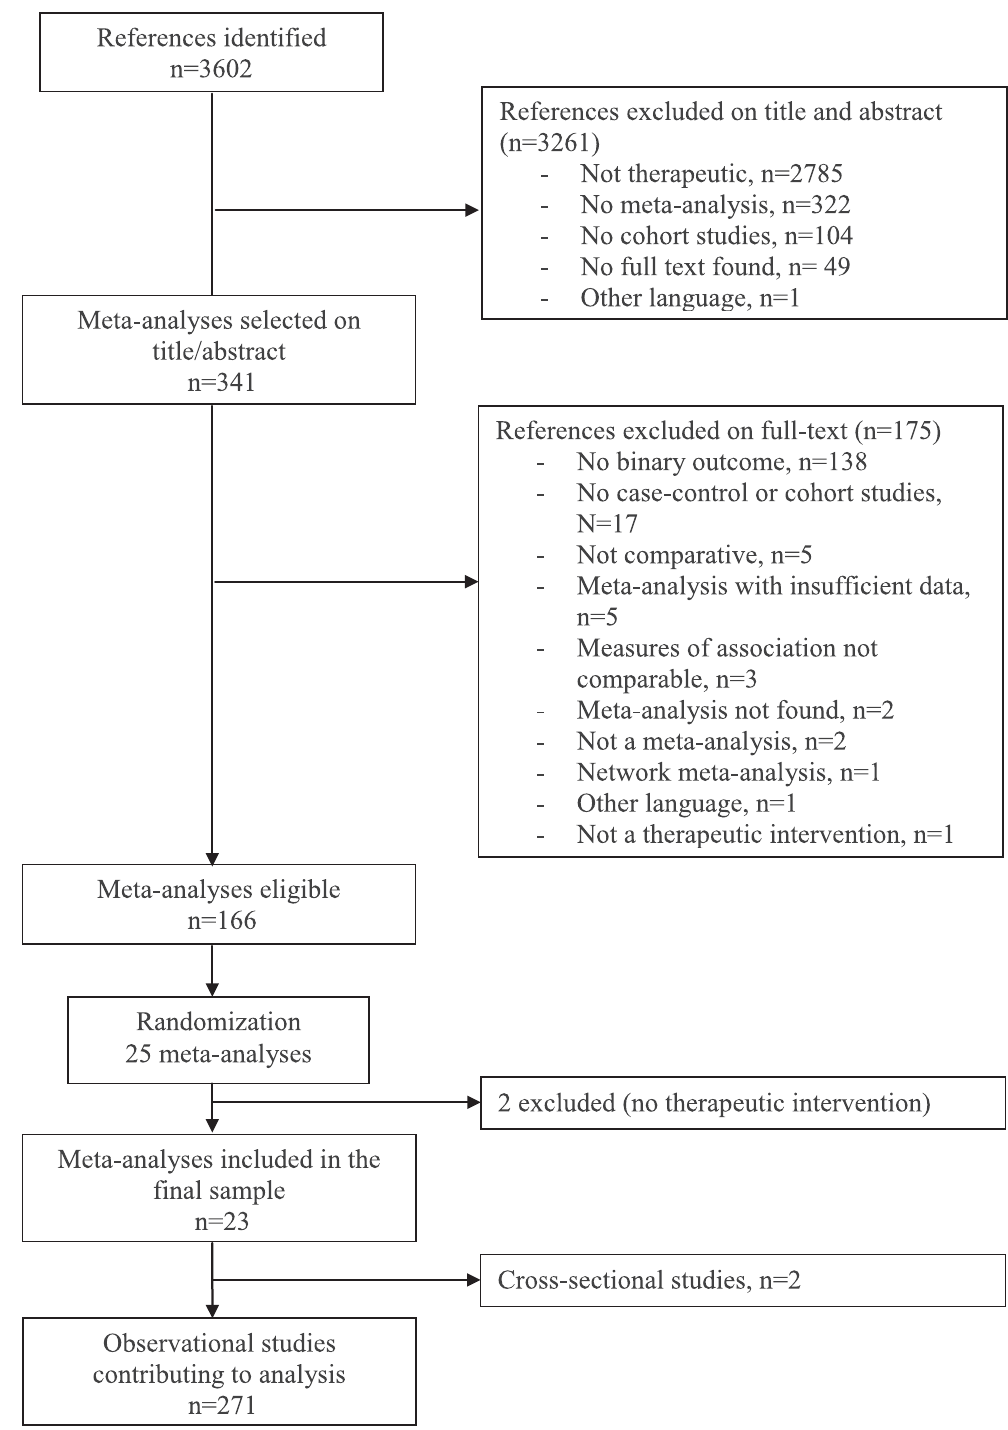
Fig 1. Flow chart of the selection of meta-analyses.